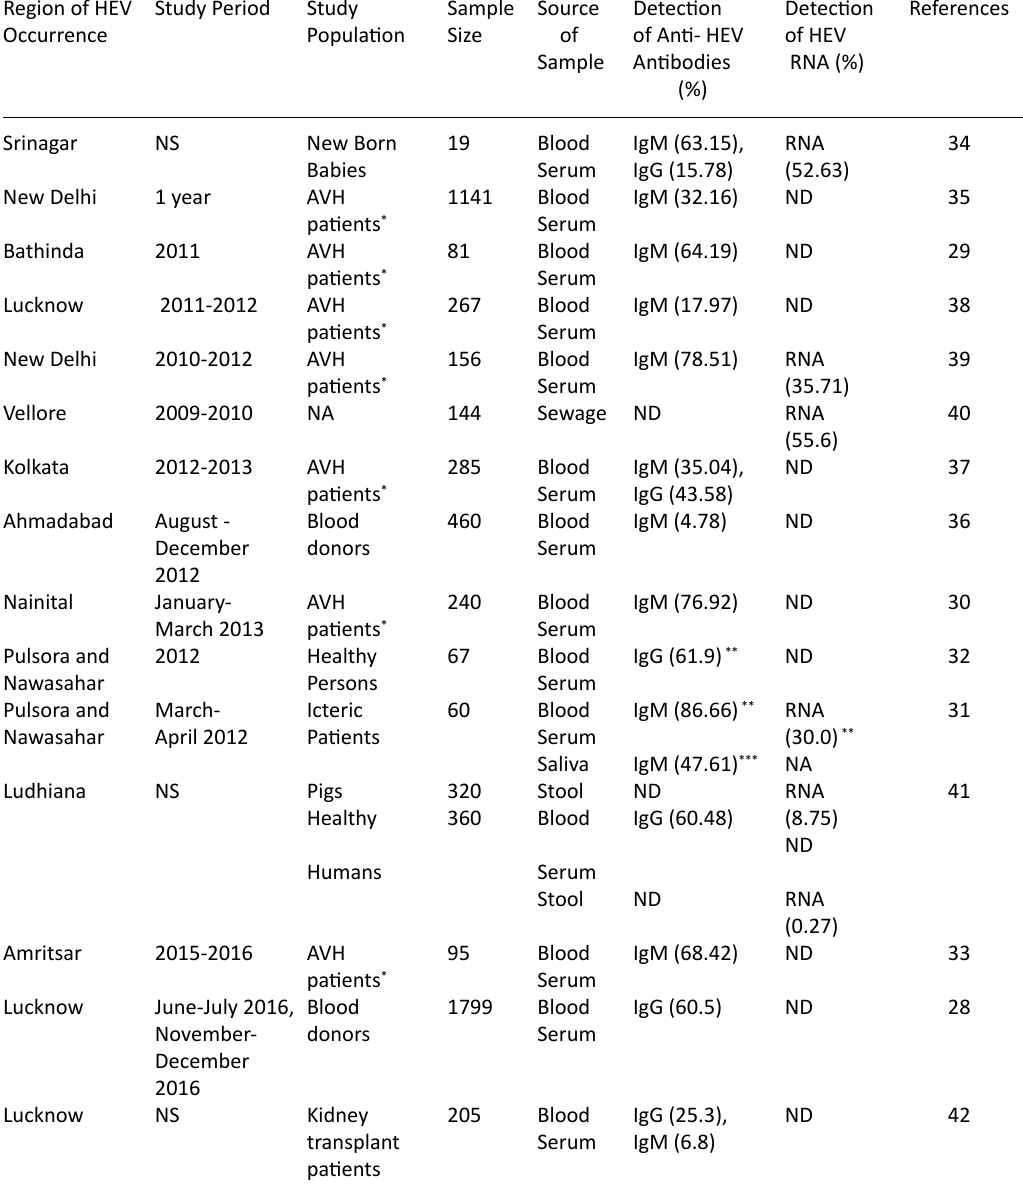
Table 1. Prevalence of Hepatitis E Virus (HEV) cases in India from 2008- 2018 Region of HEV Study